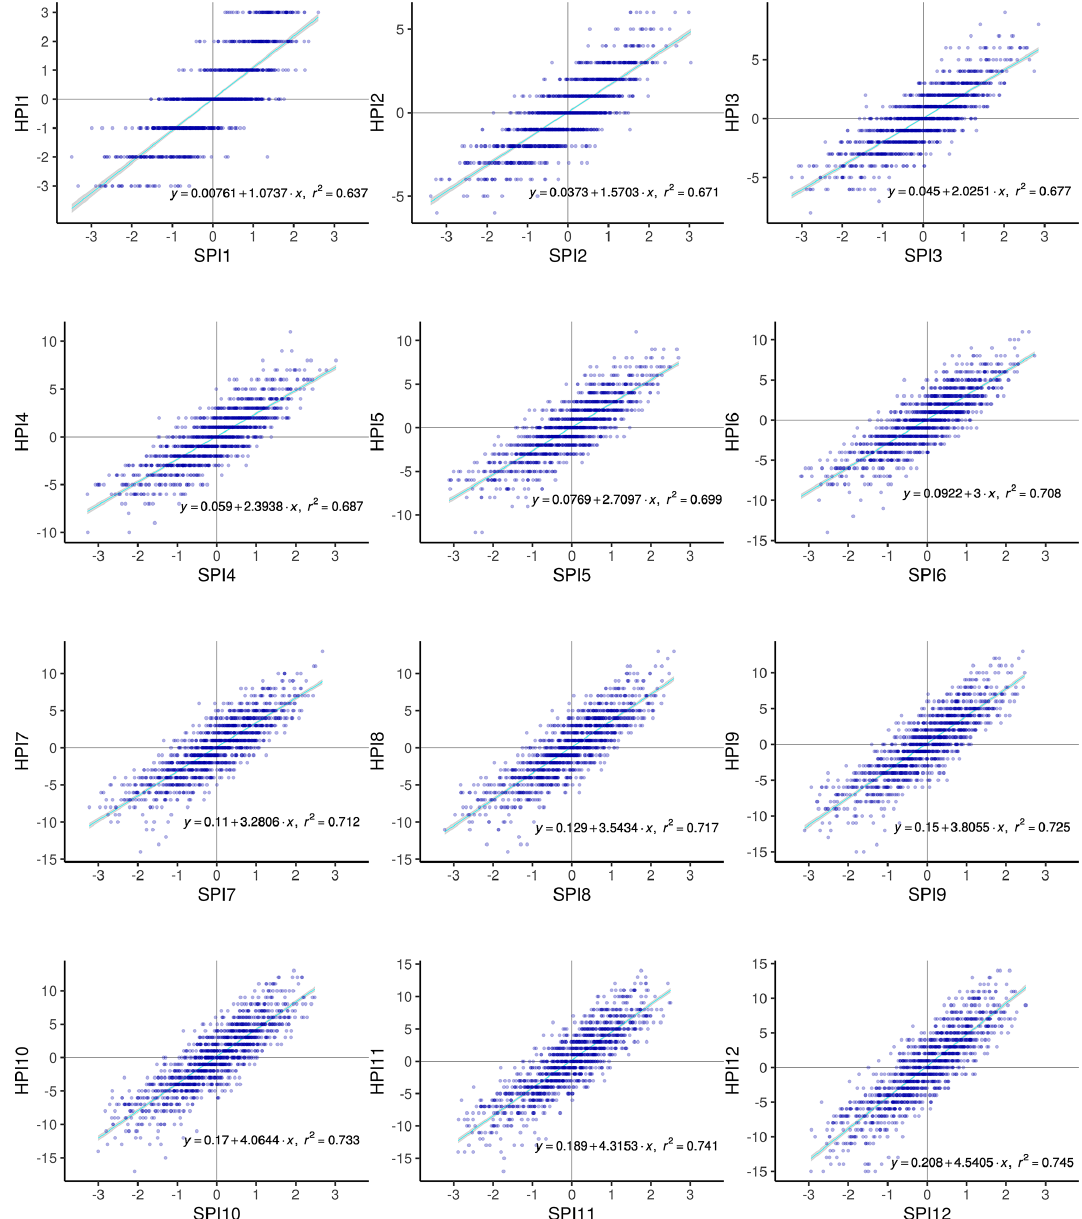
Figure 4. Strength and shape of the relationship between SPI and HPI for 1881–1996 for a duration of 1 to